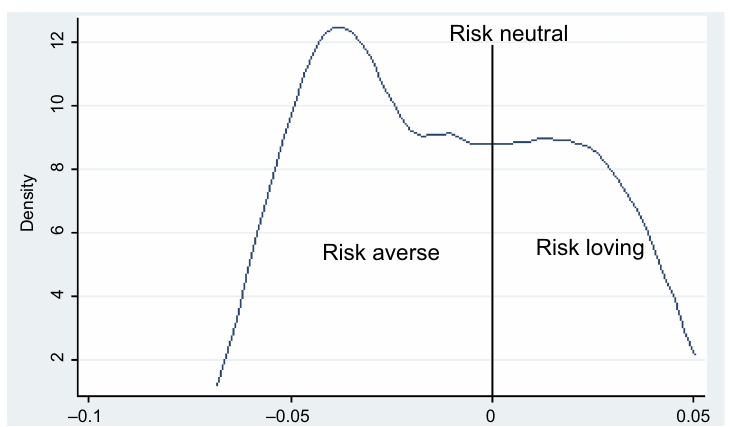
Figure 4. Risk preference of